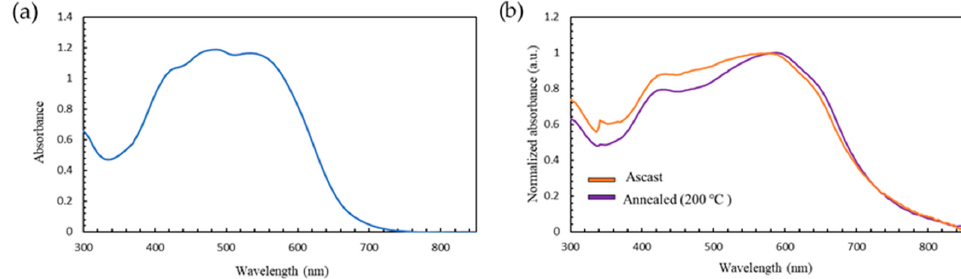
Figure 2. UV-vis absorption spectra of POTV ( a ) in chloroform and ( b ) in the films drop-cast from chloroform and annealed at 200 ◦ C at 10